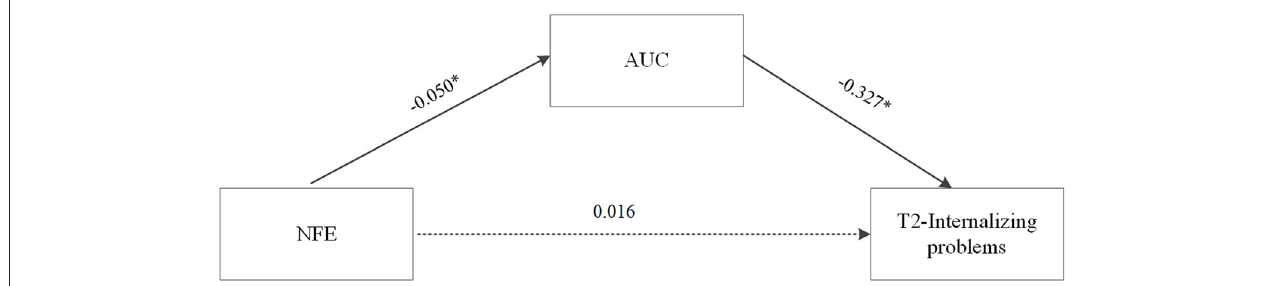
FIGURE 3 | The mediating role of AUC in the relationship between NFE and internalizing problem behaviors at T2 in left-behind adolescents. Unstandardized path coefficients were shown (NFE, negative family expressiveness, * p < 0.05).